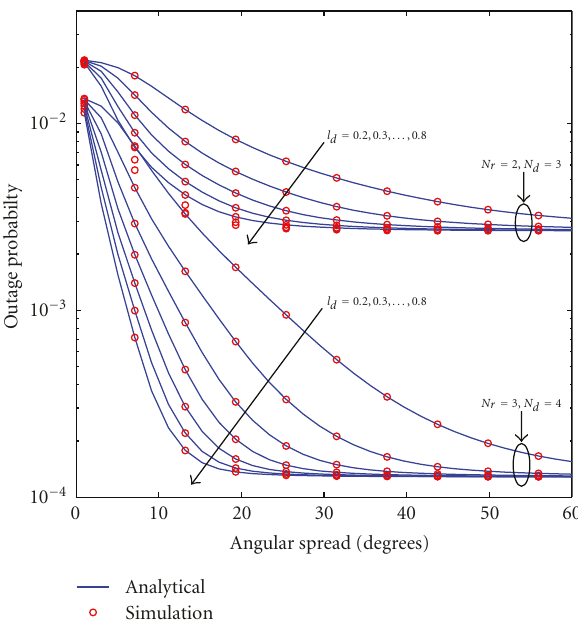
Figure 7: Average BER of dual-hop MIMO relaying over correlated Rayleigh fading channels with two antennas at the relay and four antennas at the destination. γ π/ 6.